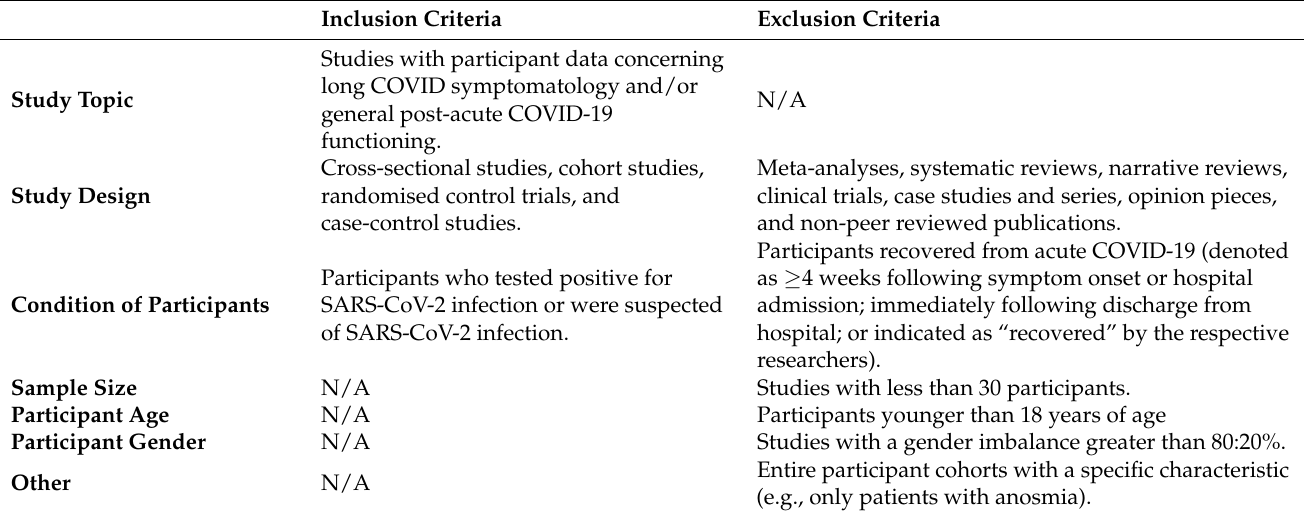
Table 1. Eligibility Criteria for Studies and